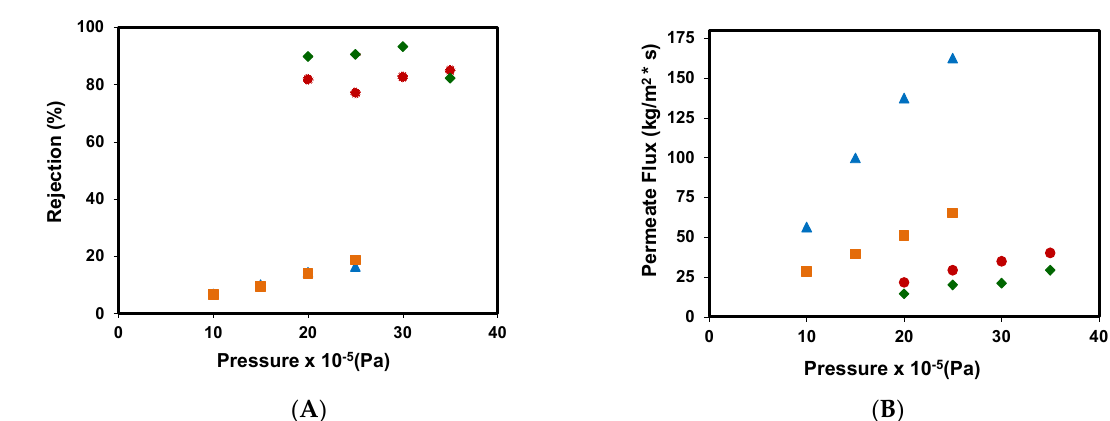
Figure 3. ( A ) Rejection coefficients and ( B ) permeate fluxes obtained for the removal of methyl paraben at different pressures for the different membranes assayed: ( ■ ) NF99, ( ) NF99HF, ( ♦ ) RO99, and (●) RO90.